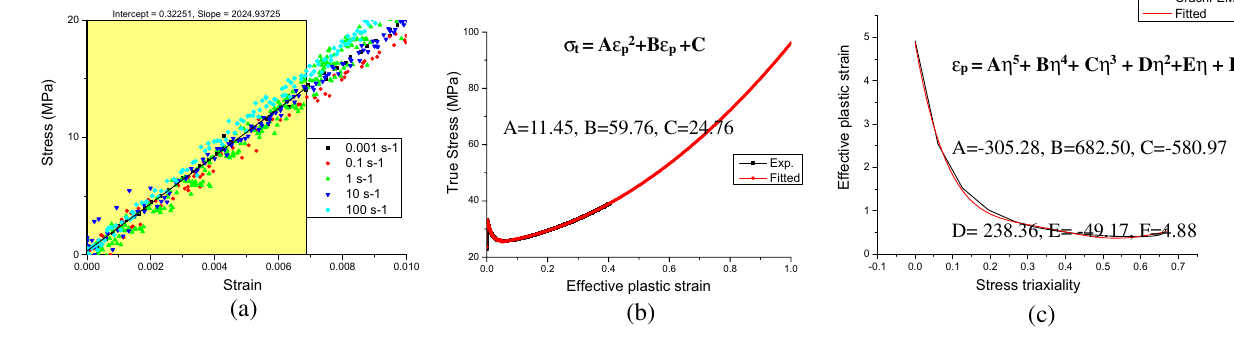
Figure 5. ( a ) Linear fit of elastic region ( b ) semi-experimental and semi-quadratic-fit of plastic region and ( c ) quantic polynomial fit of the plastic strain failure curve of